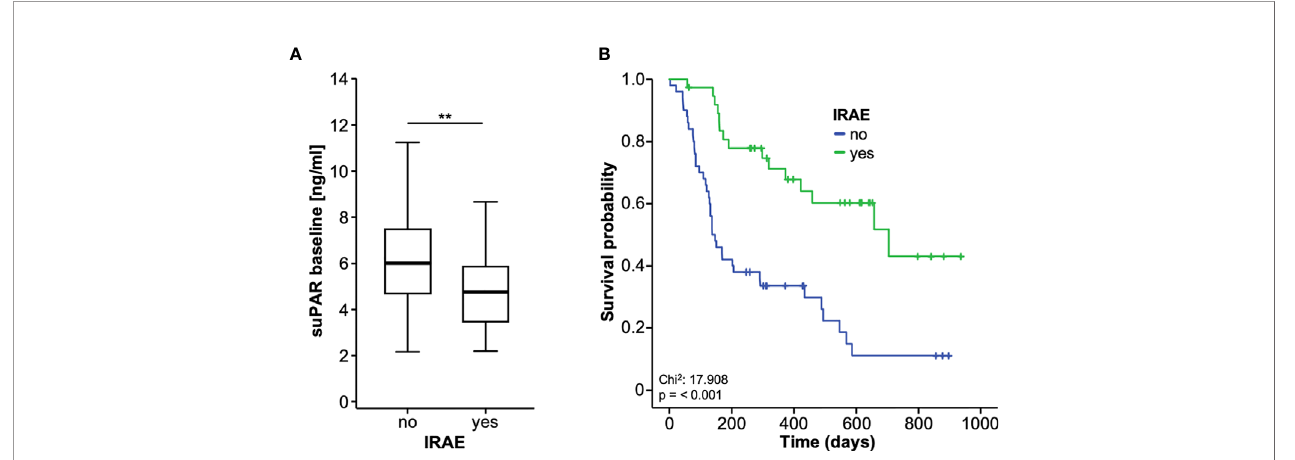
FIGURE 5 | Baseline suPAR levels correlate with side effects of ICI therapy. (A) Patients who experience immune-related adverse events (IRAE) to ICI therapy have signi fi cantly lower baseline suPAR serum levels compared to patients without IRAE. (B) Overall survival is signi fi cantly higher in the subgroup of patients experiencing IRAE. **p < 0.01.